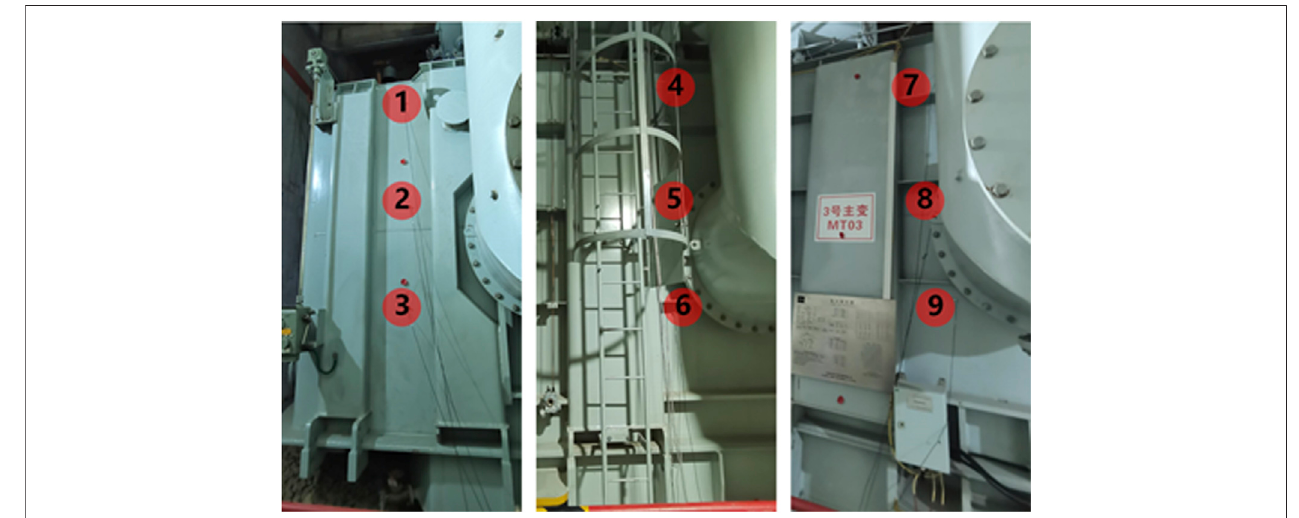
FIGURE 8 | Layout of measuring points on main